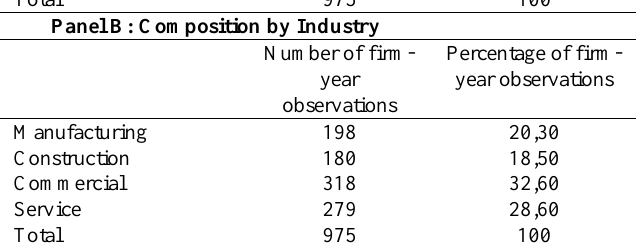
Panel B: Composition by Industry